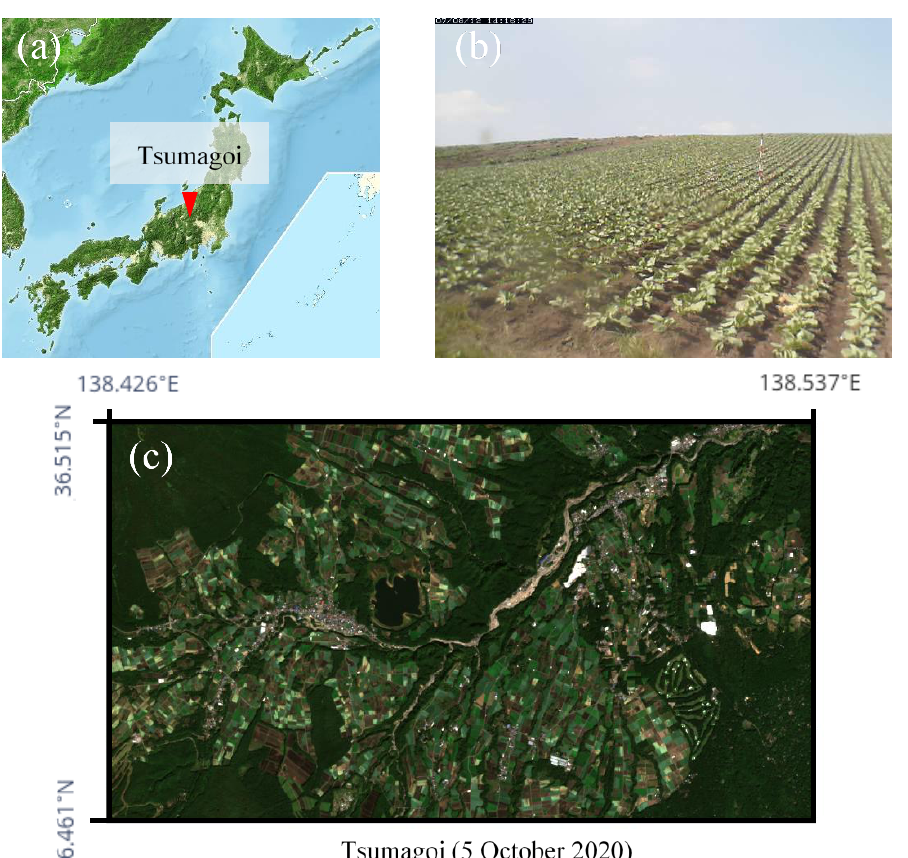
Figure 1. Information about the study area. ( a ) Location of Tsumagoi. ( b ) A web-camera image of a cabbage field in Tsumagoi. ( c ) A 10-m resolution RGB image of the target area taken by Sentinel- 2.